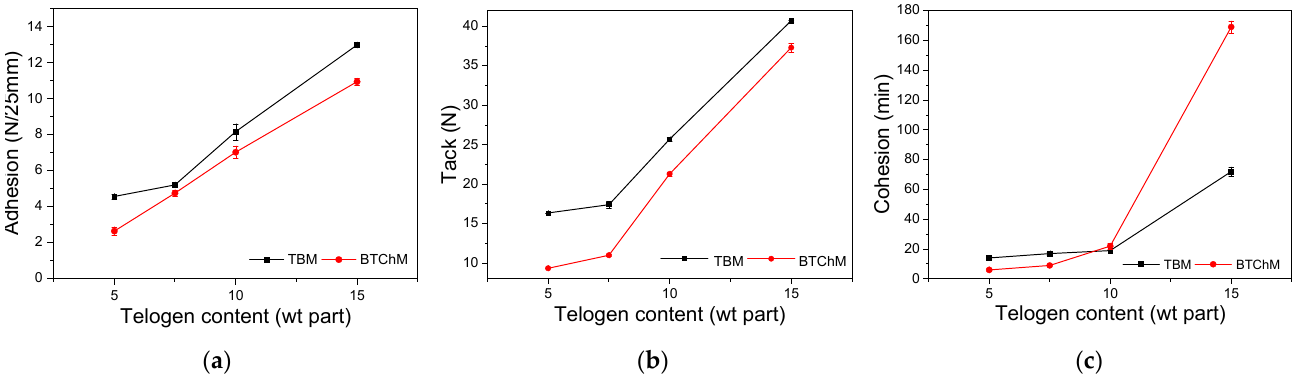
Figure 6. Adhesion to steel ( a ), tack ( b ), and cohesion ( c ) of SATs in relation to the type and content of their telogens.